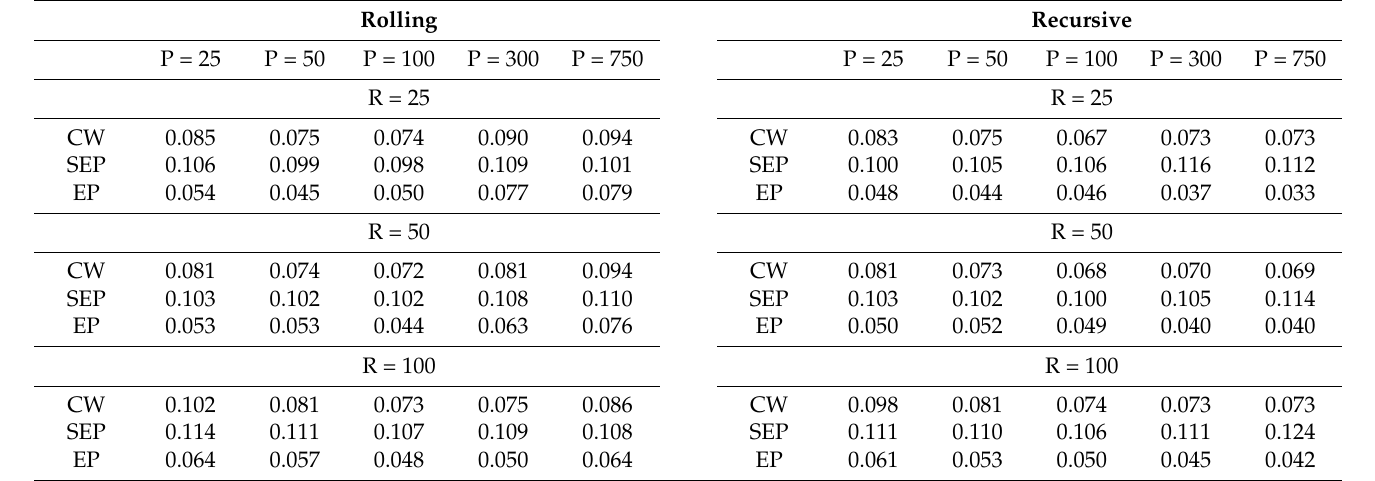
Table 6. Empirical Size DGP4, Nominal size is